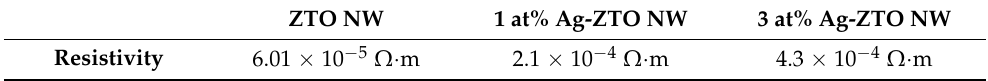
Table 1. Electrical resistivity measurements of ZTO NW, 1 at% Ag-ZTO NW and 3 at% Ag-ZTO NW. ZTO